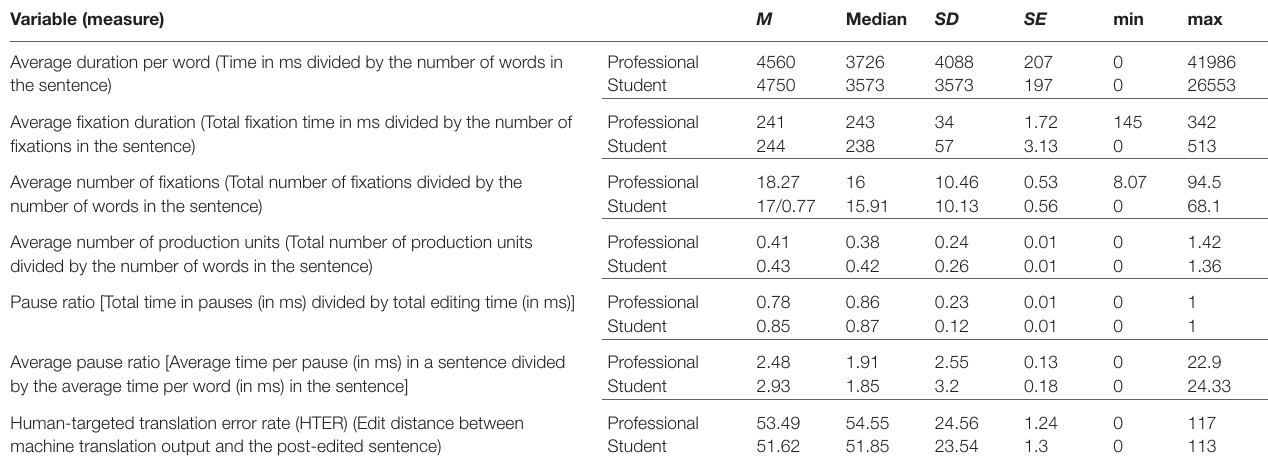
TABLE 1 | Overview of dependent variables. Variable (measure) M Median SD SE min